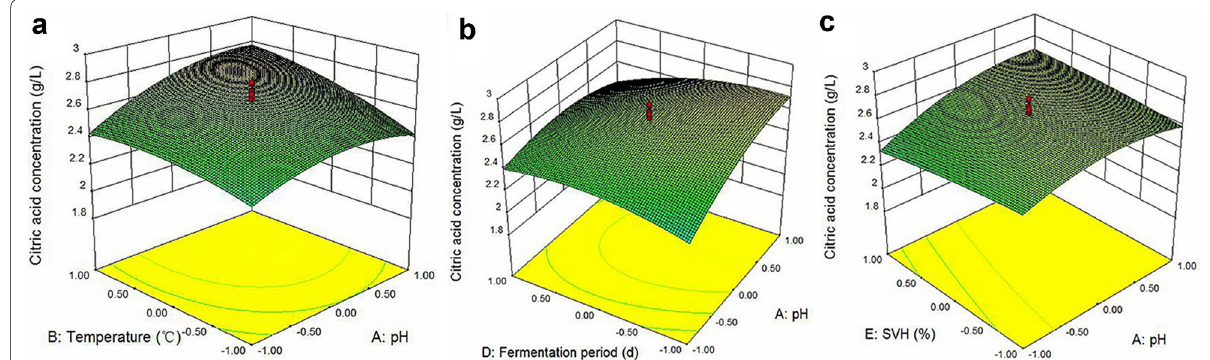
Fig. 2 Response surfaces plots for A. niger sp. ZJUY showing the interactive effects of initial pH and fermentation temperature ( a ), initial pH and fermentation period ( b ), and initial pH and SVH ( c ) on citric acid concentration,